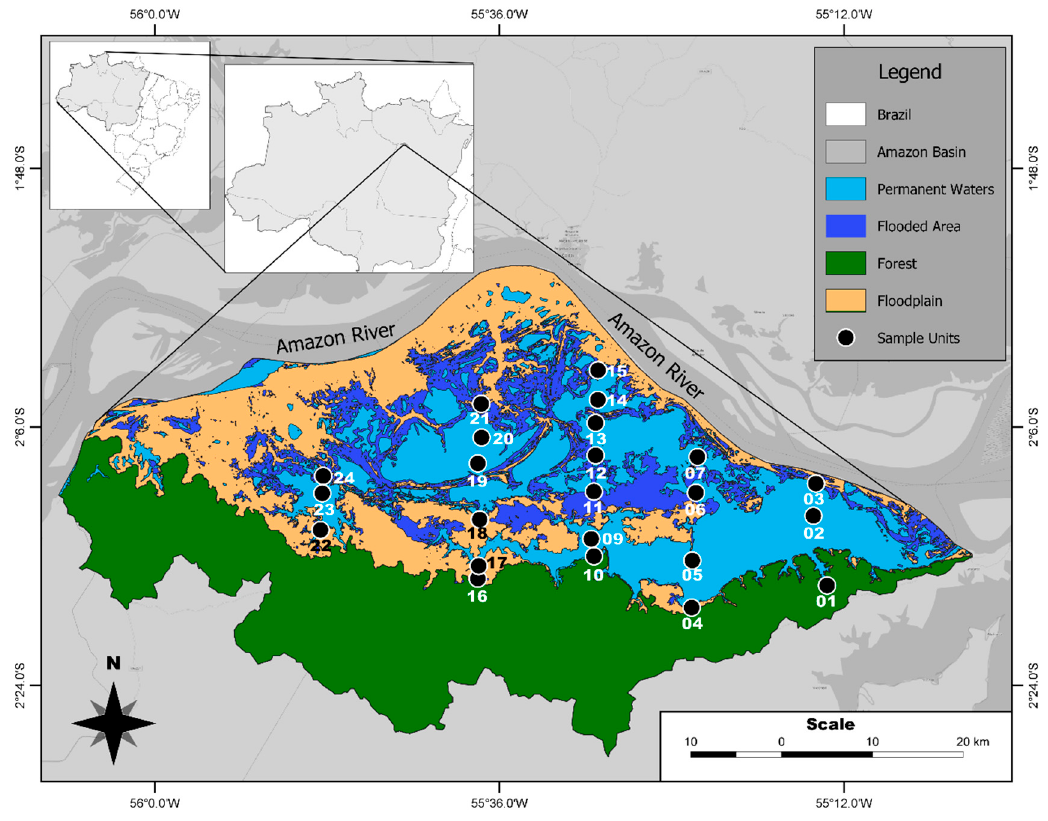
Figure 1. Map of study area, Curuai floodplain basin, with lakes sites of sampling units, flooded area and permanent waters over hydrological periods. and permanent waters over hydrological